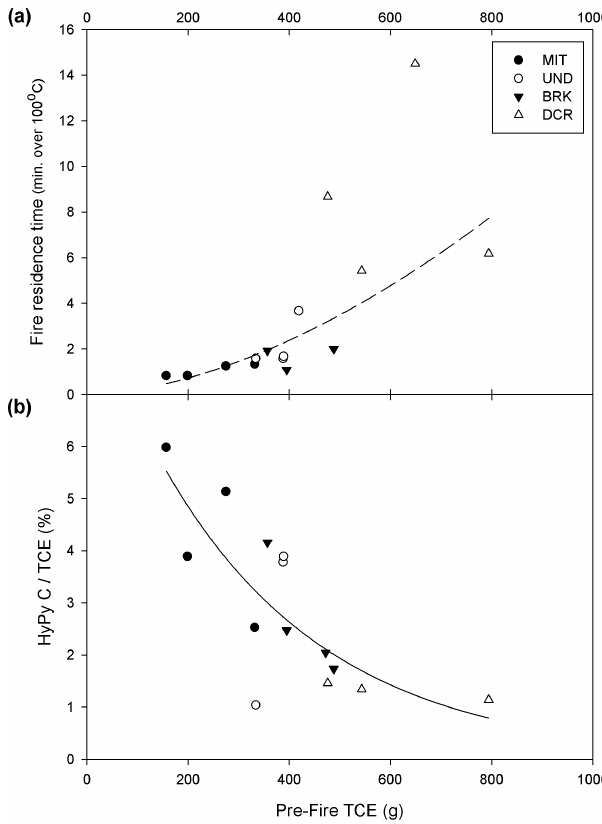
Figure 4. (a) Relationship between total carbon exposed (TCE) and fire residence time. The regression (dashed line) takes the following form: minutes over 100 ◦ C = 8 × 10 − 5 (TCE) 1 . 719 ; r 2 0.66; p < 0.05; BIC (Bayesian information criterion) 3.47; n = 14. (b) Relationship between TCE and the proportion of pyrogenic carbon produced (HyPyC) relative to TCE. The regression (solid black line) takes the following form: HyPyC / TCE (%) = 48.6– 30.9 (TCE) 0 . 066 ; r 2 0.61; p < 0.05; BIC 6.27; n = 14. Different symbols group the individual burning experiments into the different ecosystems shown in Fig. 2; individual data are presented in Table 2.